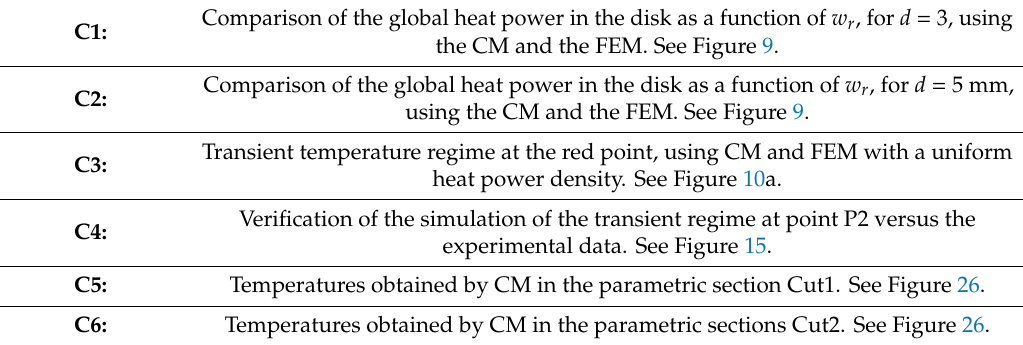
Table 2. Some numerical experiments